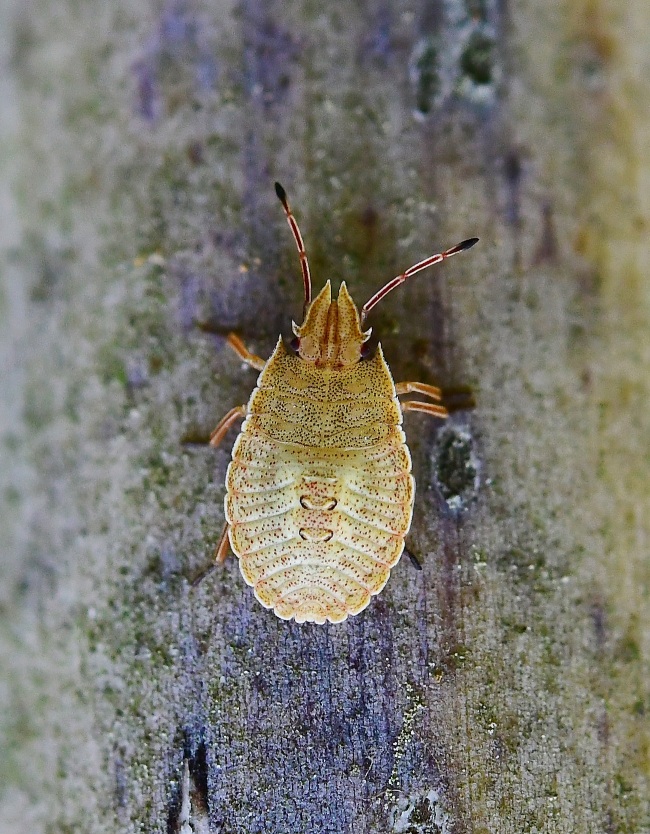
Third instar nymph.